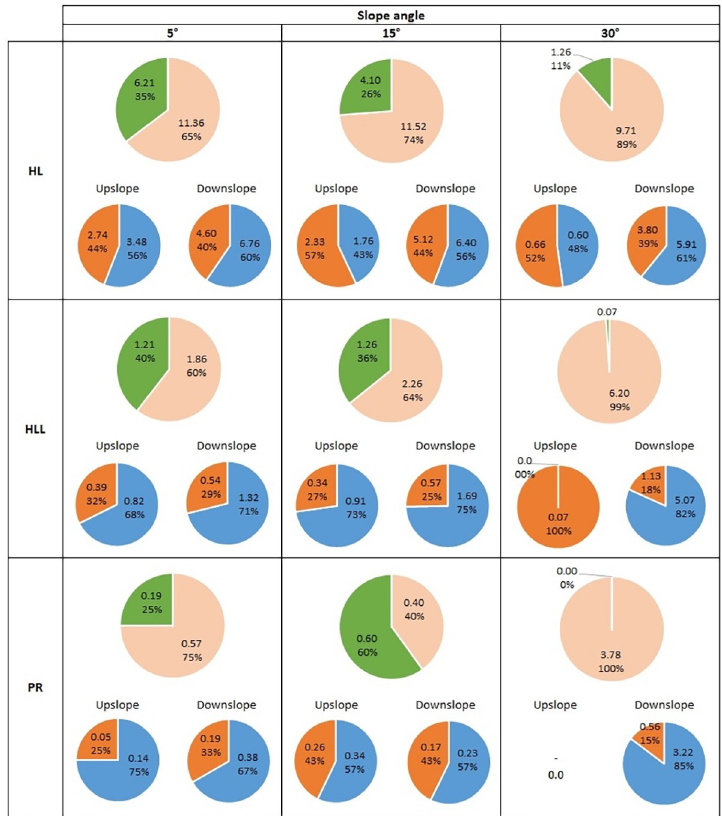
Fig 2. Proportions of the ejected material on moistened soil samples with different inclines. The upper graph shows the total material ejected into the upslope (green colour) and downslope (slight beige colour) directions. The lower graphs present the proportions of soil (brown) and water (blue) in the ejected material for both directions. Symbols of soils: HL– Haplic Luvisol , HLL– Haplic Luvisol Loamic , PR– Protic Regosol . All values are expressed in [mg]